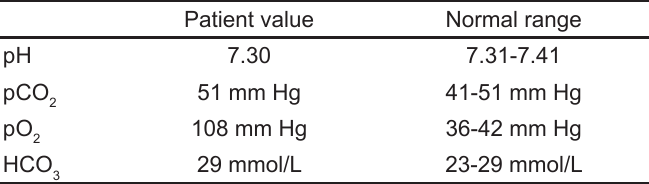
Table 2. Venous blood gas of 40-year-old female with sudden onset